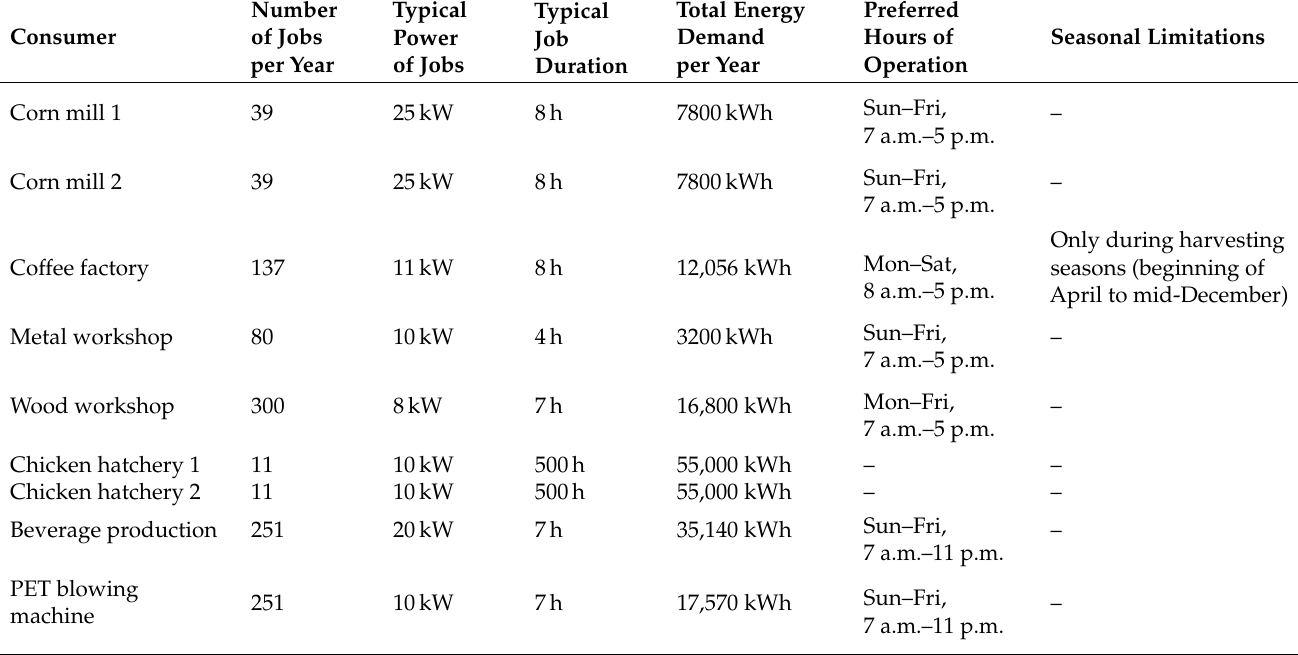
Table 5. Description of the scheduled consumers in the test